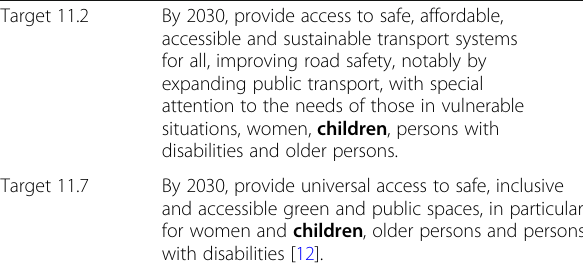
Table 1 Child related indicators in Sustainable Development Goal 11: Make cities and human settlements inclusive, safe, resilient and sustainable (emphasis added) Target